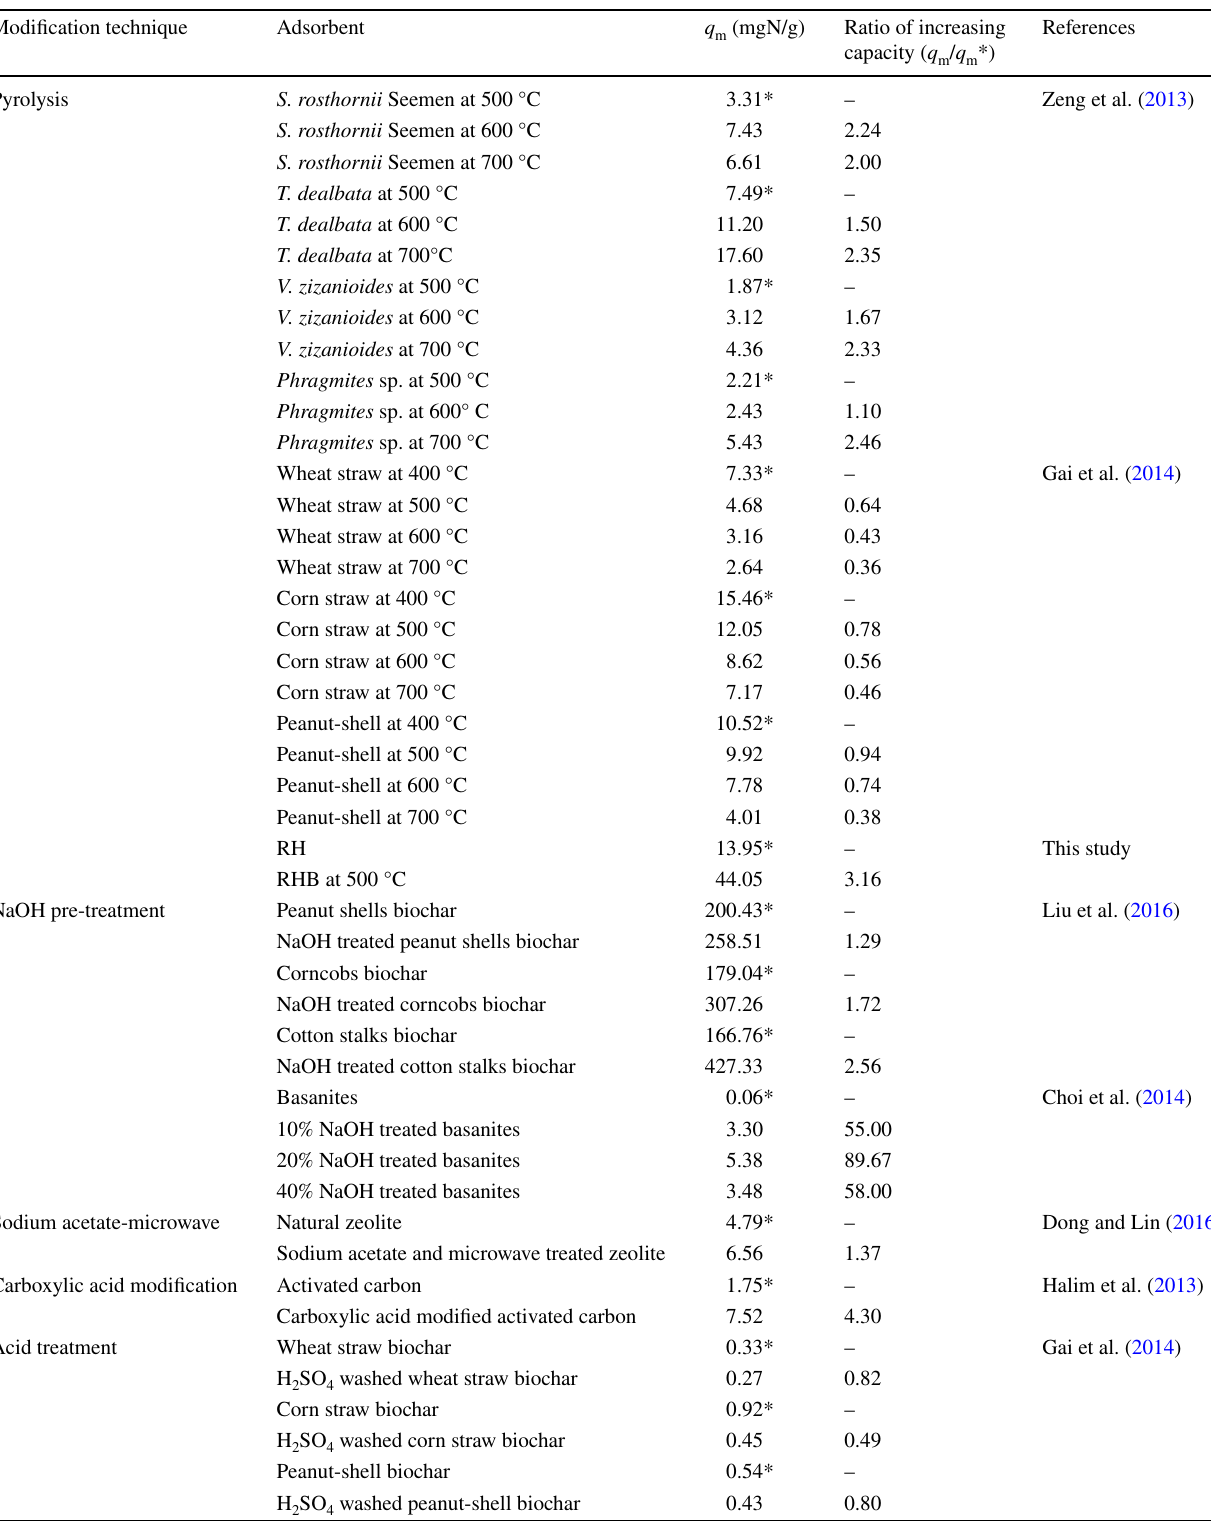
Table 3 Comparison of surface modification technique on increasing adsorption capacity of ammonium Modification